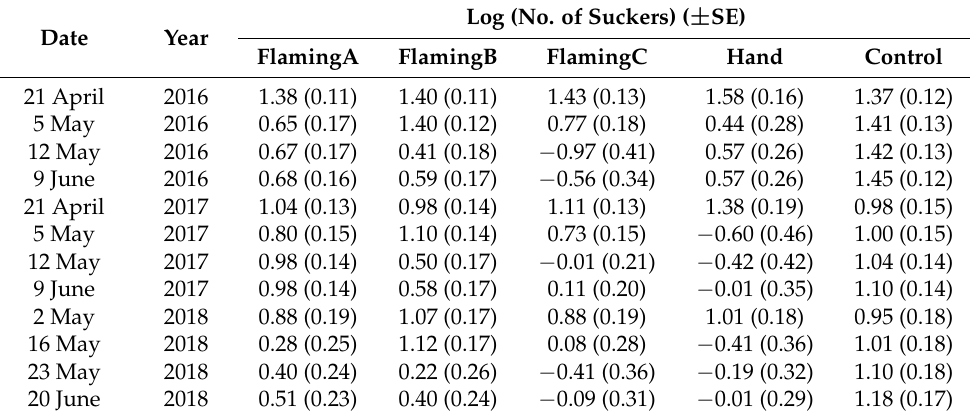
Table 2. Least squares means of the number of suckers per plant log transformed and standard errors (SE) as affected by different types of suckering methods and data collection date in the three-year experiment. These data are useful for computing all pairwise comparisons.